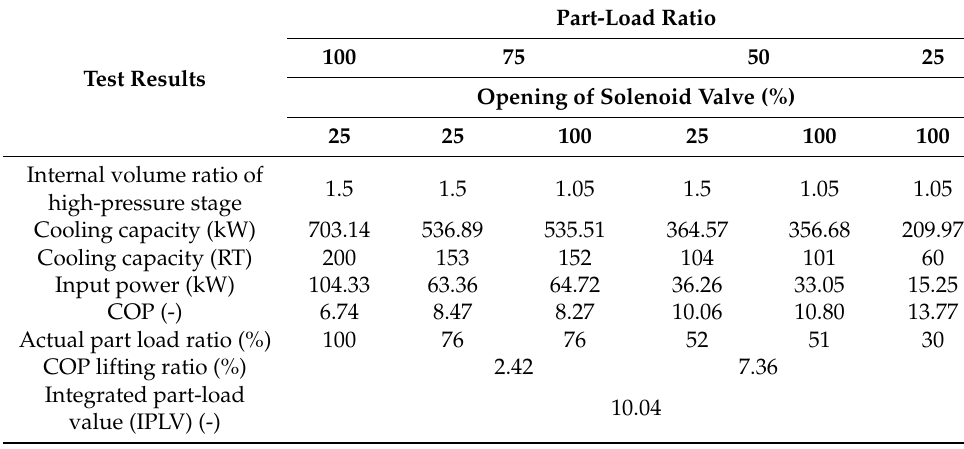
Table 4. Part load performance test results of the